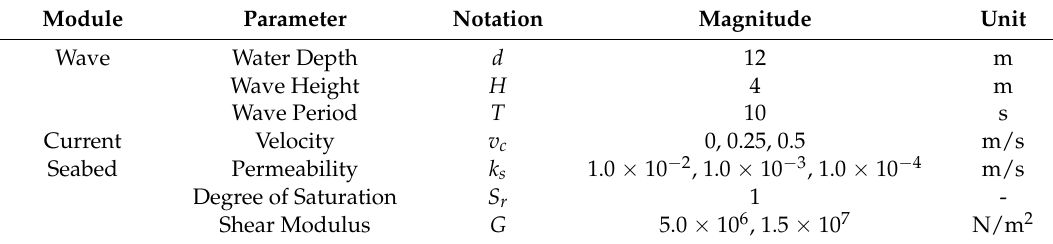
Table 1. Input data for the numerical